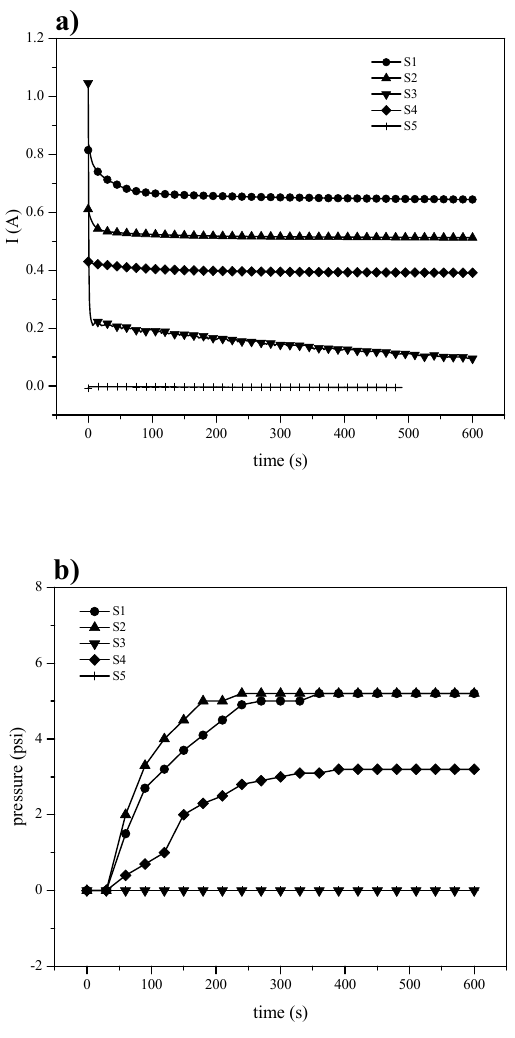
Figure 8. Electrochemical hydrogen pumping at 300 mV ( a ) current and ( b ) pressure.